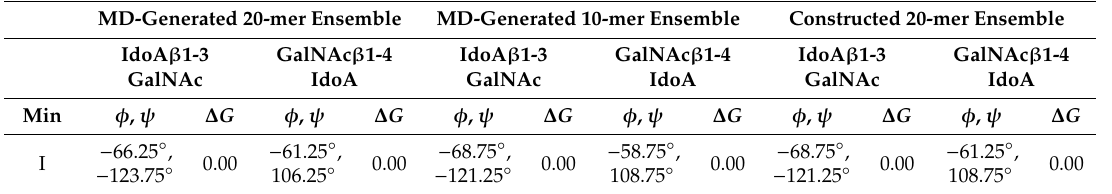
1 φ , ψ dihedral angles were sorted into 2.5 ◦